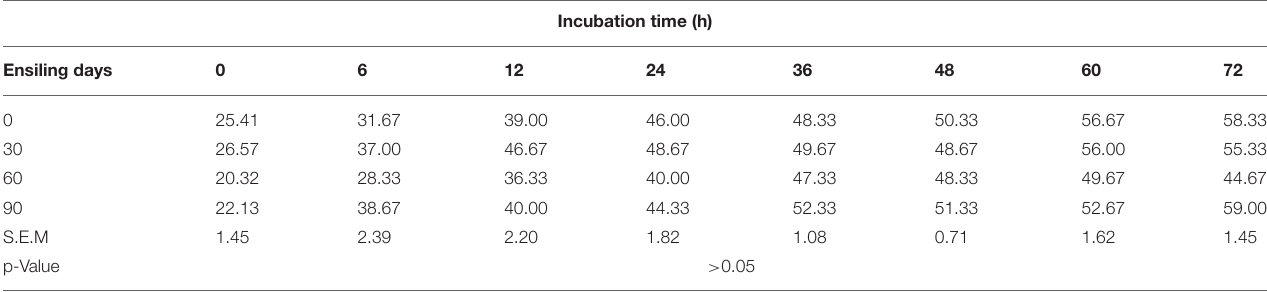
TABLE 8 | Effect of ensiling duration on average crude protein (CP) degradability of forage rape silage after 0-, 6-, 12-, 24-, 36-, 48-, 60-, and 72-h incubation in situ